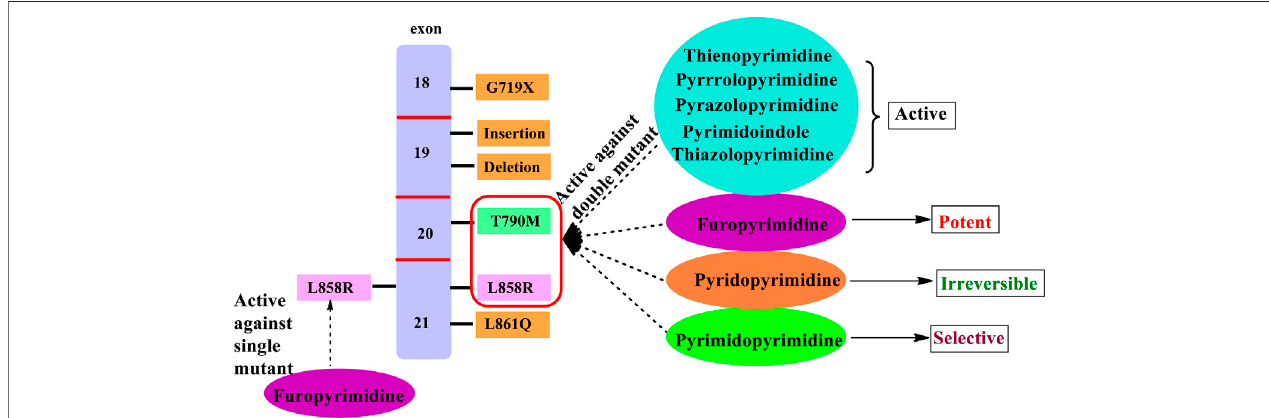
FIGURE23| Mechanism ofpyrimidine-basedhybridsininhibiting EGFR. Themutationmainlyoccursat the T790M and L858Rexons.From the knownchemistry, various hybrids act differently on this mutated exon. Furopyrimidine shows inhibitory activity not only to L858R but also to the double mutant T790M and L858R. Pyridopyrimidine, thienopyrimidine, pyrrolopyrimidine, pyrimidopyrimidine, pyrimidoacridone, pyrazolopyrimidine, pyrimidoindole, and thiazolopyrimidine are active against the double mutant T790M and L858R. Pyridopyrimidine is the irreversible inhibitor, whereas pyrimidopyrimidine is a selective